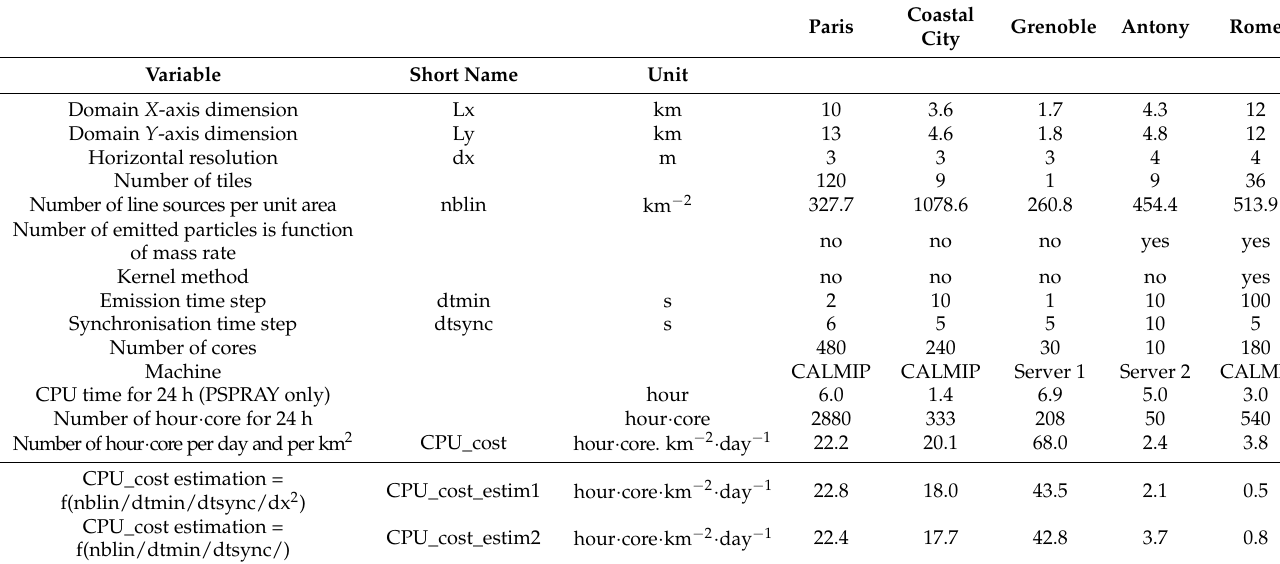
Table 6. Modelling setup parameters, effective CPU demand for dispersion part with PSPRAY model, and estimation through a simple linear fit. The CALMIP calculation center server used is EOS. It is constituted of nodes with Intel IvyBridge @2.80 GHz (20 logical cores per node). The server1 and server2 are internal calculation servers, respectively constituted of two intel Xeon E5-2640 V4 @2.40 GHz (40 logical cores) and two Intel Xeon X5680 @3.33 GHz (12 physical cores without hyperthreading). The two last lines give estimations of CPU based on input parameters and a simple linear fit.